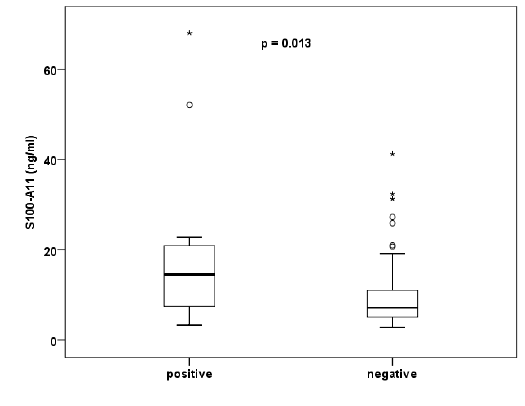
Figure 7: S100-A11 serum levels in lymphonode positive (positive, n=14), and lymphonode negative (negative, n=84) endometrial cancer